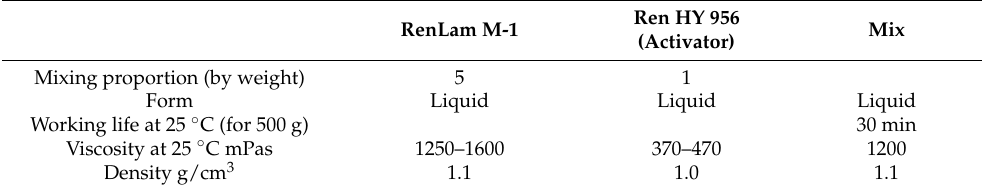
Table 2. Physical properties of the resins used for part casting (RenLam M1 and Ren HY 956).